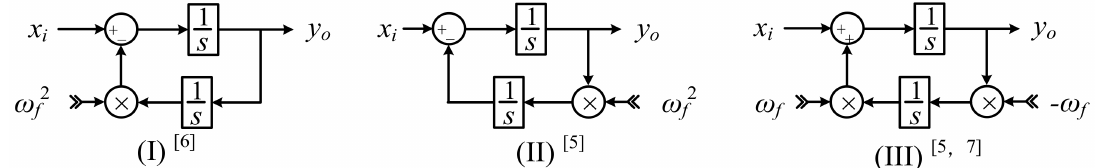
Figure 1. Implementations of the resonant term of frequency adaptive proportional resonant (PR) controllers based on two